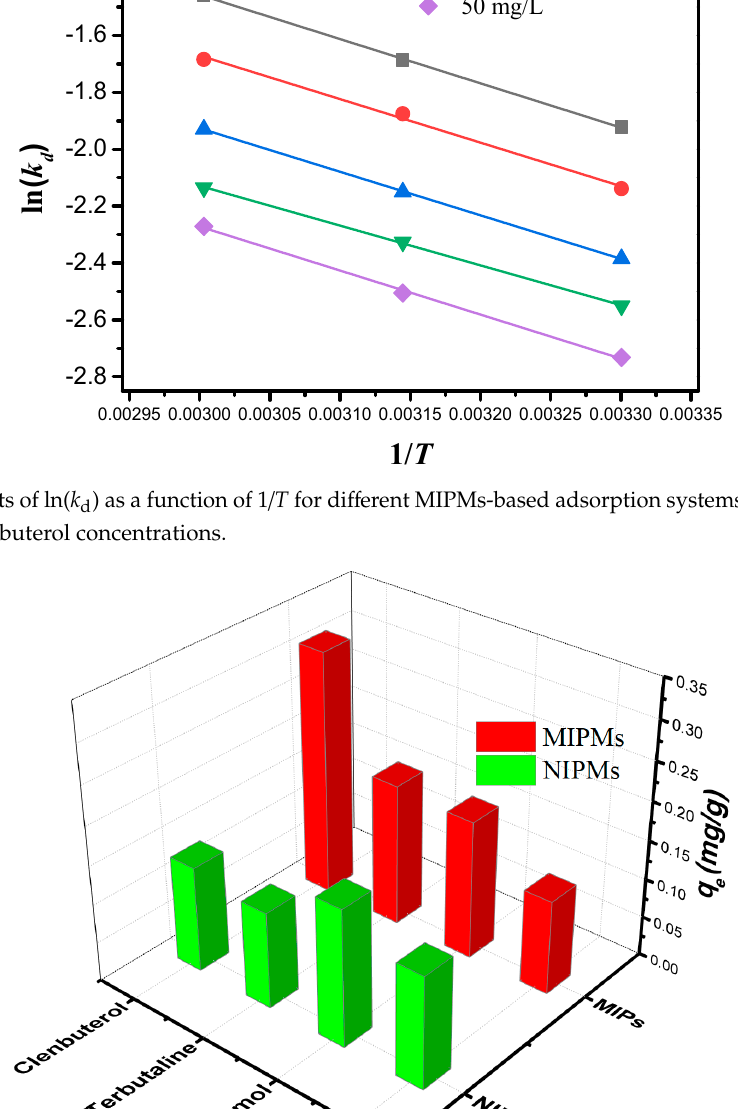
Figure 11. Recycling performance of the MIPMs when used as the stationary phase of the MISPE column for processing of clenbuterol solution through the evaluation of the spike recovery for each cycle. 4. Conclusions We have effectively employed Pickering emulsion polymerization and molecular imprinting manufacturing to produce the MIPMs with recognition sites complementary to the clenbuterol template in the size and functionalities. Numerous cavities are generated on the surface of MIPMs as a result of molecular imprinting, in stark contrast to the NIPM surface. On the other hand,